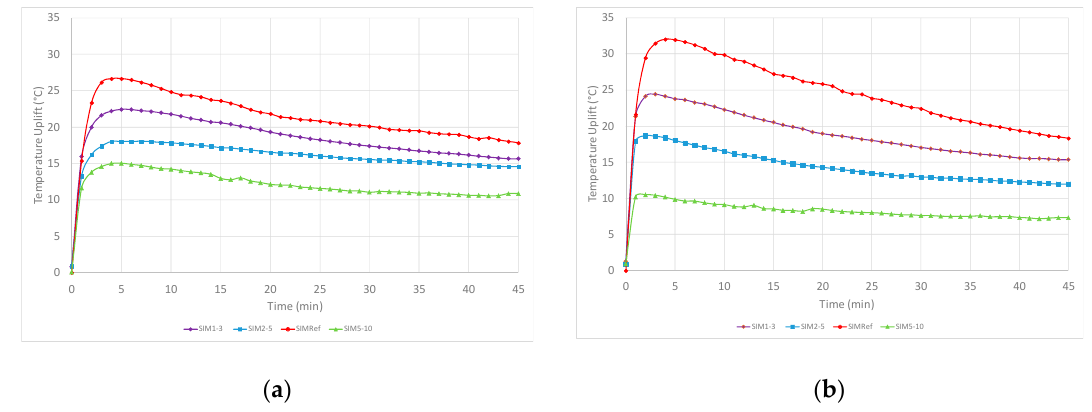
Figure 8. The impact of particle size on reactor thermal response when filled with SIM particles of varying size at ( a ) 20 and ( b ) 30 L/min.